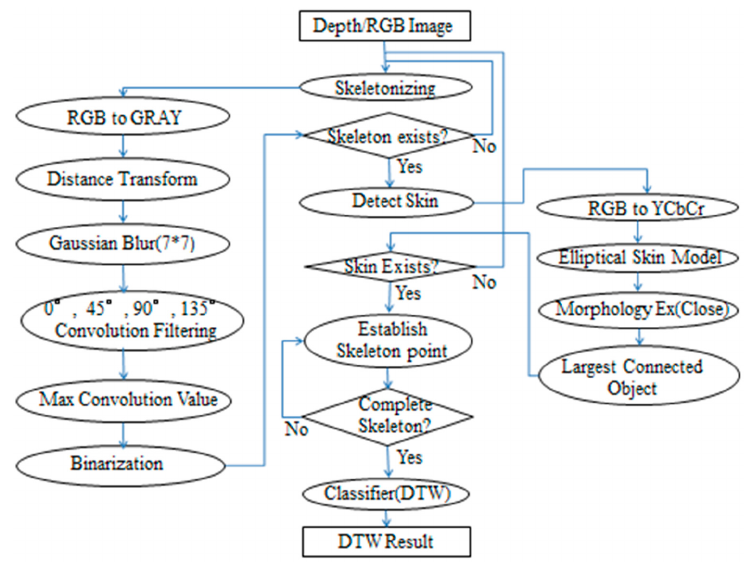
Figure 1 . System block diagram of the proposed upper extremity rehabilitation system. Figure 1. System block diagram of the proposed upper extremity rehabilitation